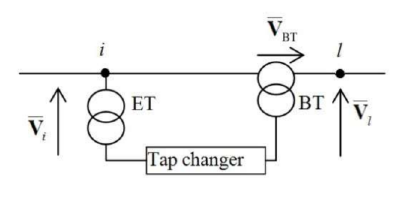
Figure 1. An equivalent circuit of the phase shifter.